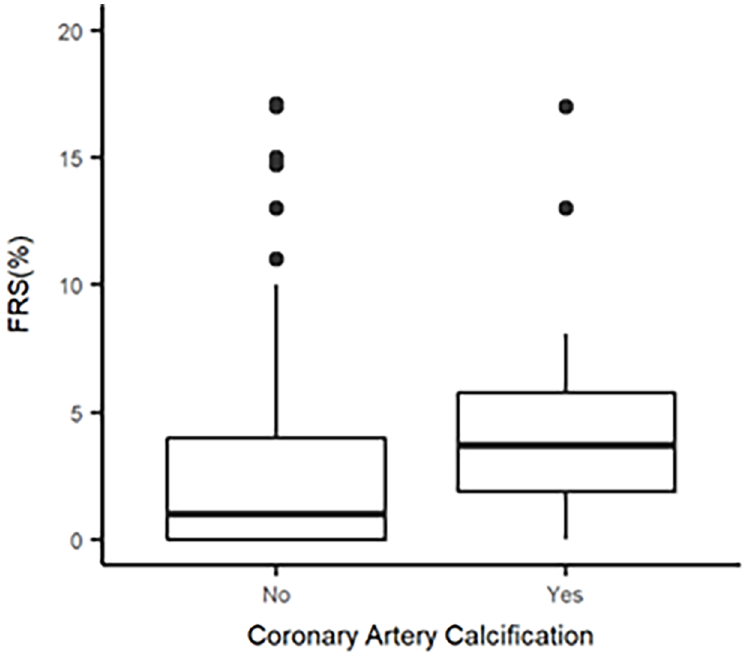
Fig 3. Calcification as a binary categorical variable by quantitative cardiovascular risk. Box plot showing bulk of higher Framingham risk score values in the calcification group. CACS = Coronary artery calcium score; FRS = Framingham risk score.